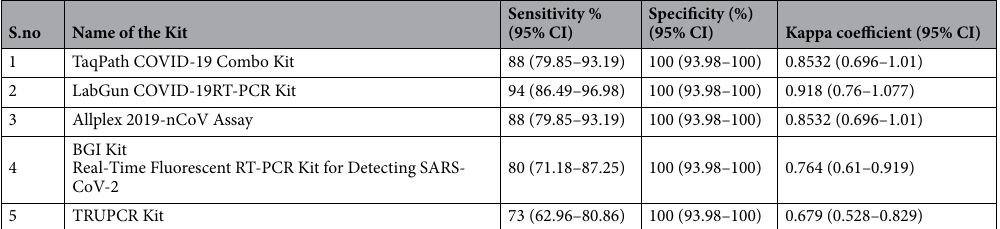
Table 1. Obtained sensitivity and specificity of various RT-qPCR Kits in this study on COVID-19 positive cases.